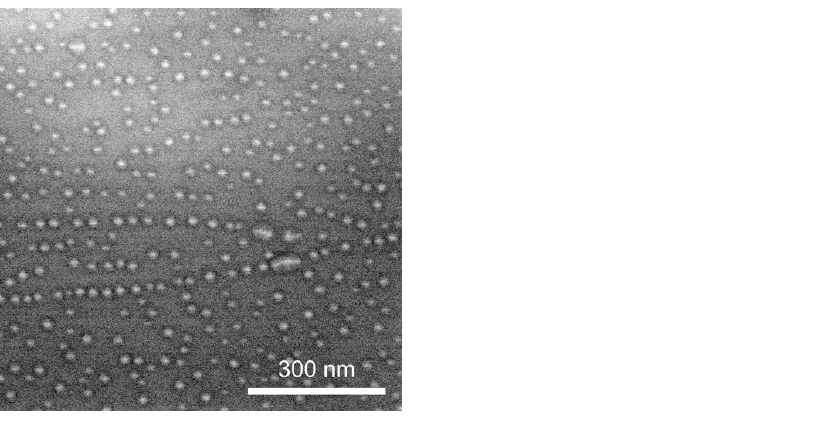
Figure 2. SEM image of an array of uncovered InAs QDs formed on the GaAs surface (sample 0). PL spectra taken from the overgrown structures demonstrate their strong dependence on the arsenic pressure used during overgrowth of QDs by the LT-GaAs layer (Figure 3a). For each room-temperature spectrum, the lines corresponding to volume GaAs and InAs wetting layer are at ~870 and 935 nm, respectively, which is in good agreement with previous studies [20]. However, longer-wavelength lines corresponding to the energy levels of QDs differ in their position and relative intensity (Table 1).